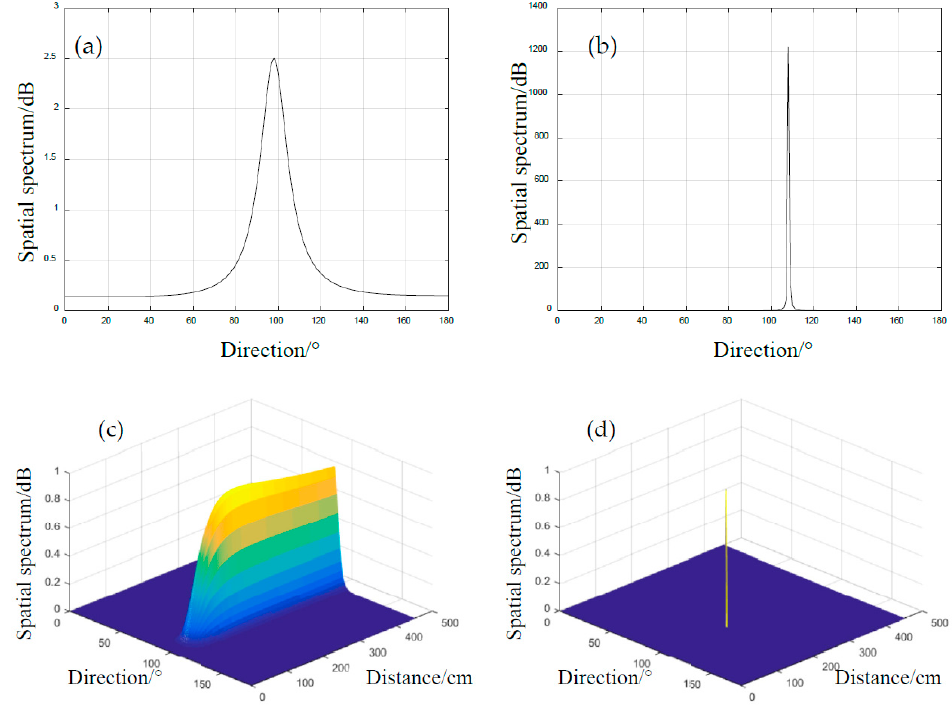
Figure 9. Spatial spectrum of case #2 at (189 mm, 102 ◦ ) estimated by ( a ) classical 1D-MUSIC algorithm, ( b ) error calibration based 1D-MUSIC algorithm, ( c ) standard 2D-MUSIC method and ( d ) the proposed